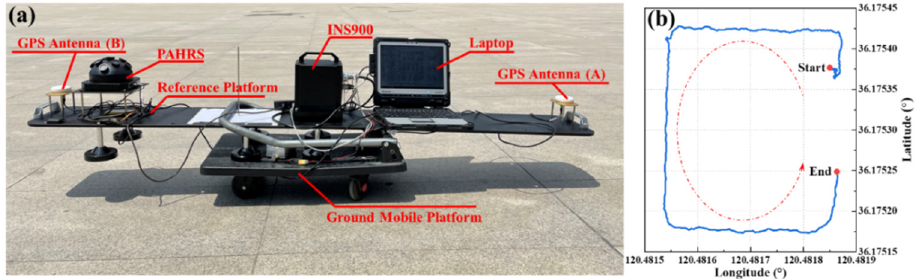
Figure 13. The real-world experiment setup ( a ) and motion trajectory ( b